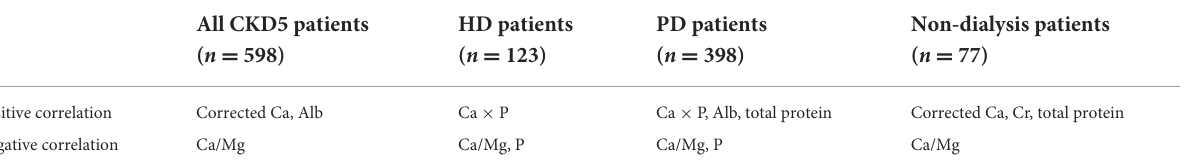
TABLE 8 Summary of influencing factors of serum Mg in different subgroups in this study.